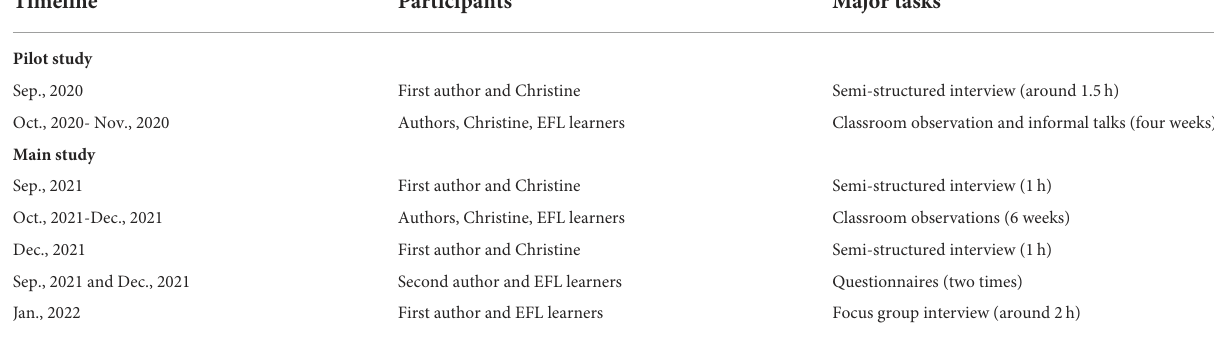
TABLE 1 Research design of the current